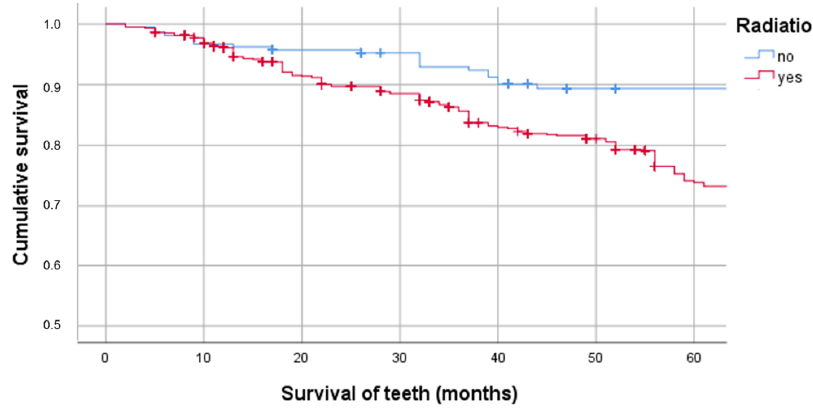
Figure 1. Cumulative survival of teeth in irradiated and non-irradiated patients.